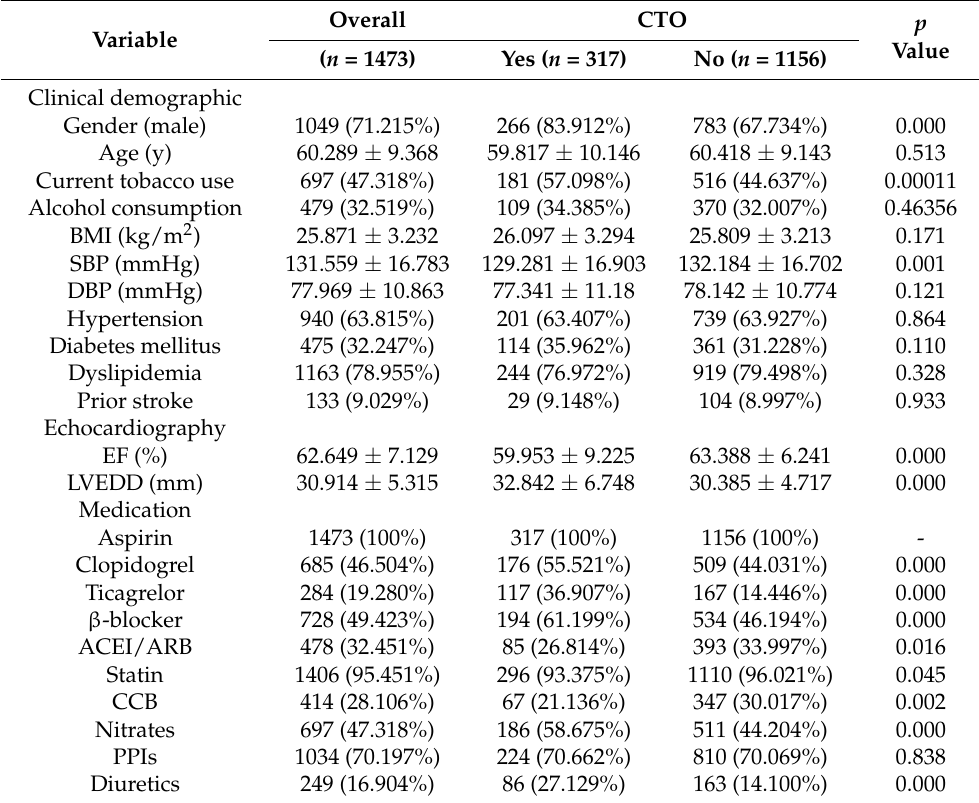
Table 1. Baseline clinical demographic of study patients.